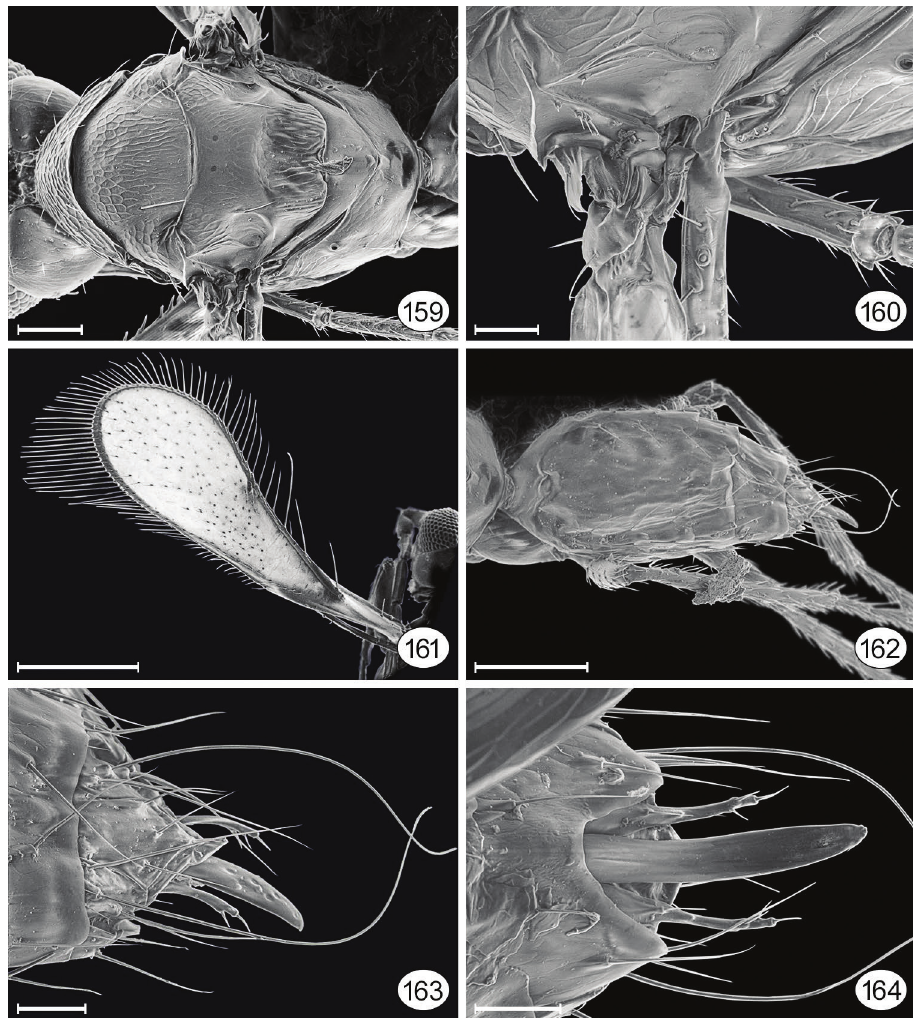
Figures 159–164. Proarescon similis , male. 159 mesosoma, dorsal 160 base of wings + axilla, dorsal 161 fore wing, dorsal 162 mesosoma, laterodorsal 163 apex of gaster + genitalia, dorsolateral 164 apex of gaster + genitalia, ventral. Scale bar for 159 = 50 μm; 160, 163, 164 = 20 μm; 161 = 200 μm; 162 = 100 μm. and 2 short setae towards anterior margin. Propleuron faintly, longitudinally reticulate, with 1 seta medially and 1 seta laterally about midway between anterior and posterior apices. Prosternum apparently smooth, with 1 seta submedially almost at anterior mar- gin. Mesoscutum with sculpture isodiametric anteriorly and on lateral lobes to longi- tudinally reticulate posteriorly on midlobe, with 1 setae along inner margin midway between anterior and posterior apices of notaulus, and 1 setae at lateral angle of lateral lobe. Anterior scutellum smooth, with 1 setae laterally at dorsal margin of axillula, and with campaniform sensilla about 2× their diameter from transscutal